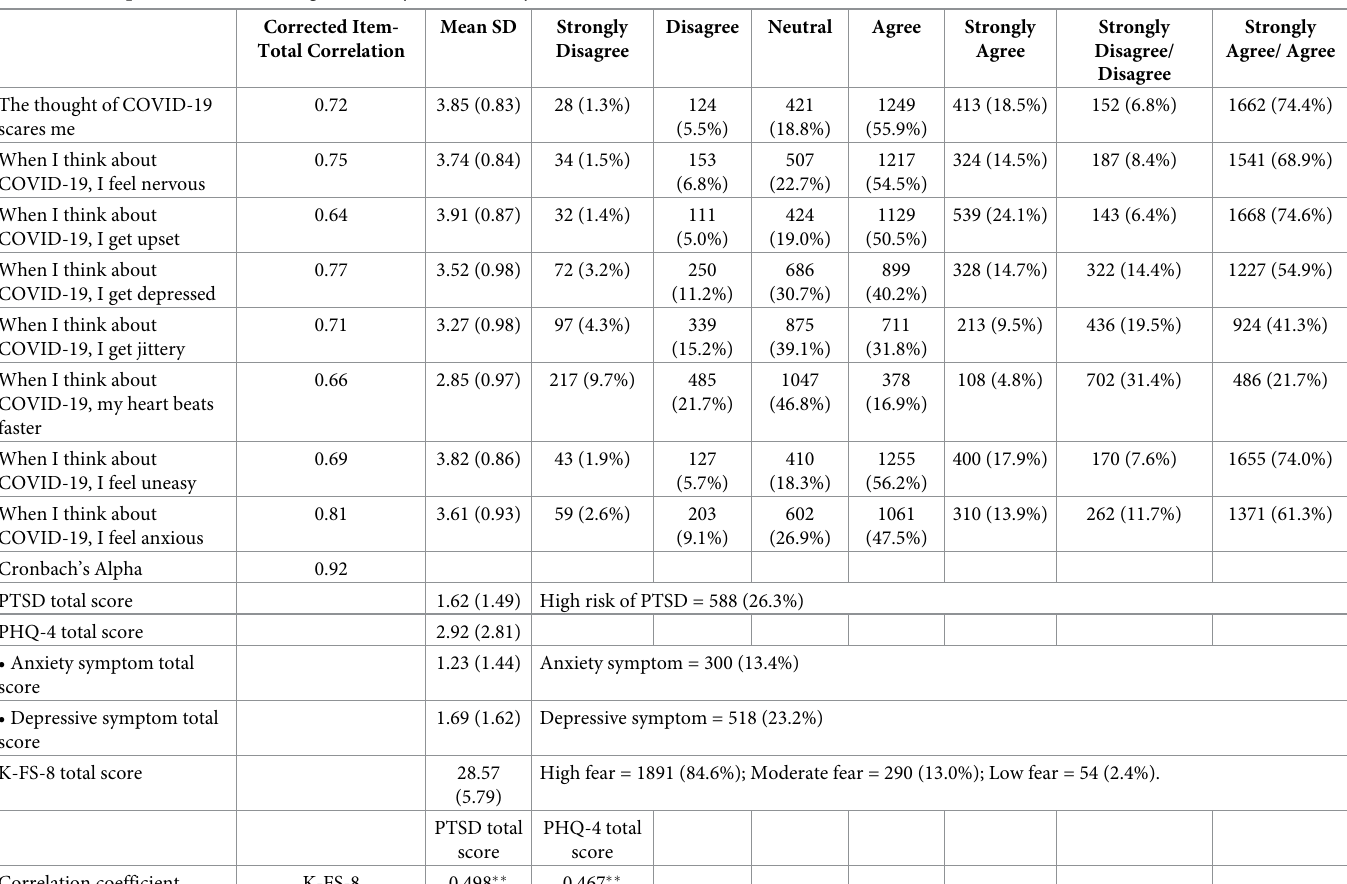
Table 2. Descriptive statistics, convergent validity and